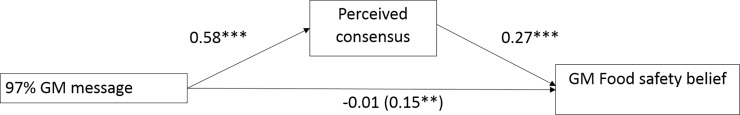
The effect of a 97% GM message on belief that GM food is safe to eat, mediated via perceptions of consensus among climate scientists, controlling for pre-treatment consensus estimates.Standardized regression coefficients. ***p < .001. N = 253.